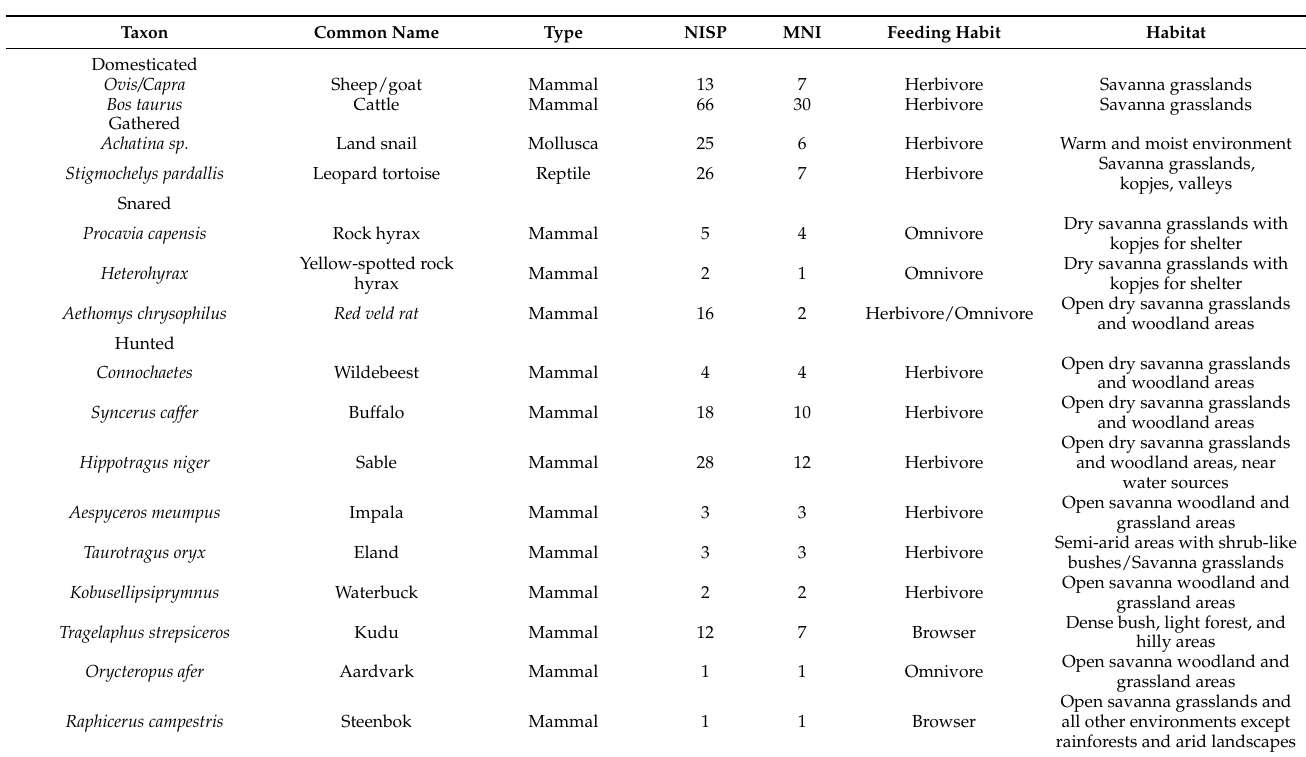
Table 2. The range of domestic and wildlife species represented by faunal remains that were recovered at Chumnungwa. Their feeding habits and habitat preferences are also highlighted (adapted from Ref.